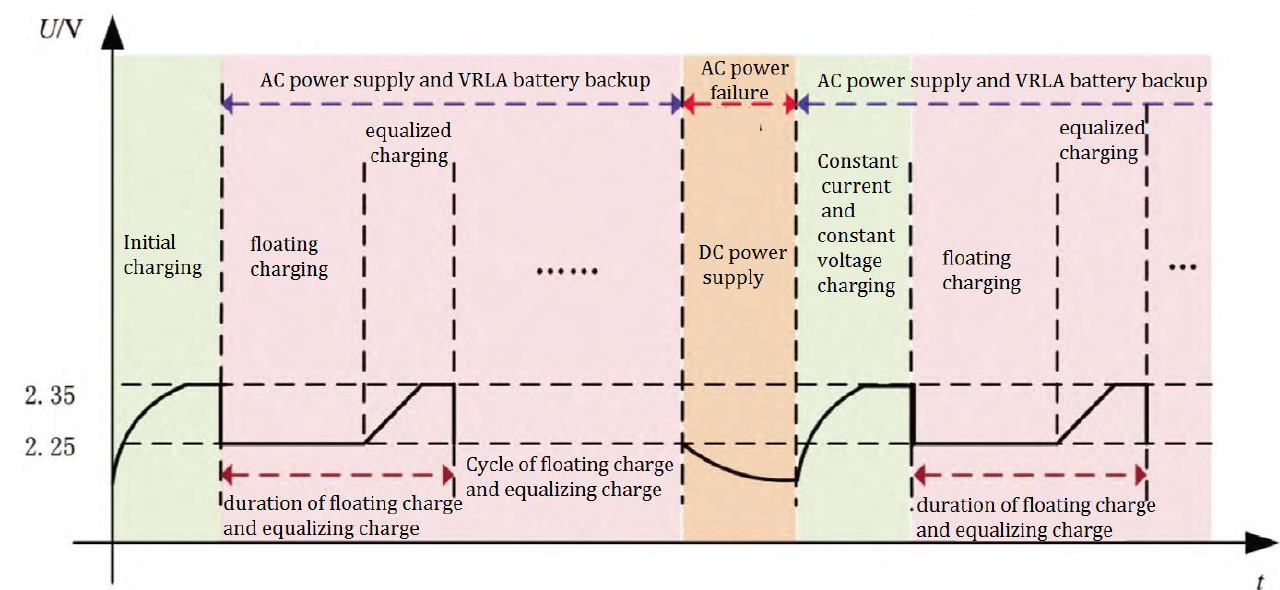
Figure 1. Charging and discharging operation mode diagram of a VRLA battery [12]. Adapted with permission from Ref. [12]. 2022, Chinese Journal of Power Sources magazine.